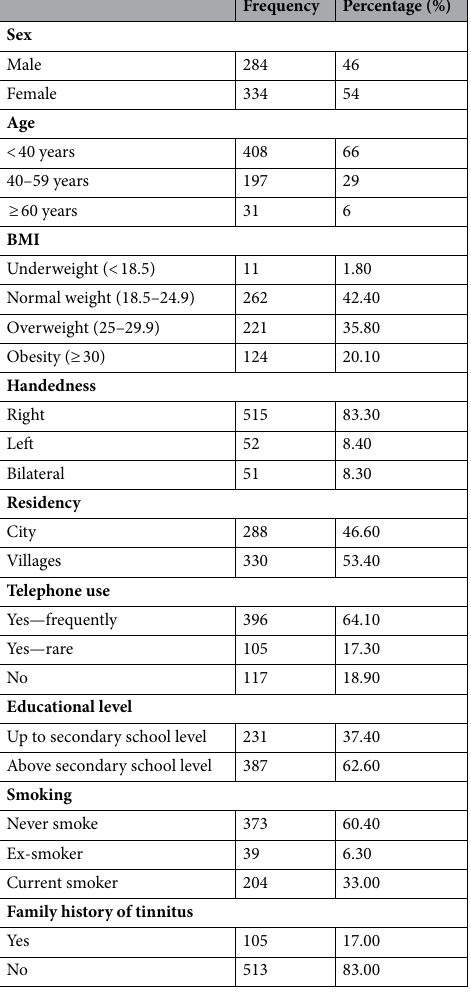
Table 1. Background Characteristics of the study participants (n =